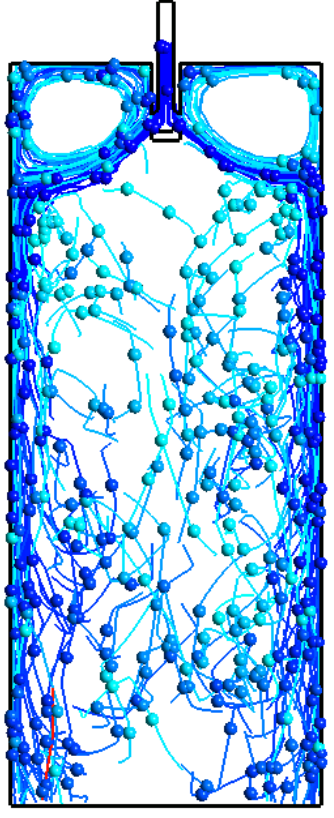
Figure 10. Alumina inclusion motion in the mold.